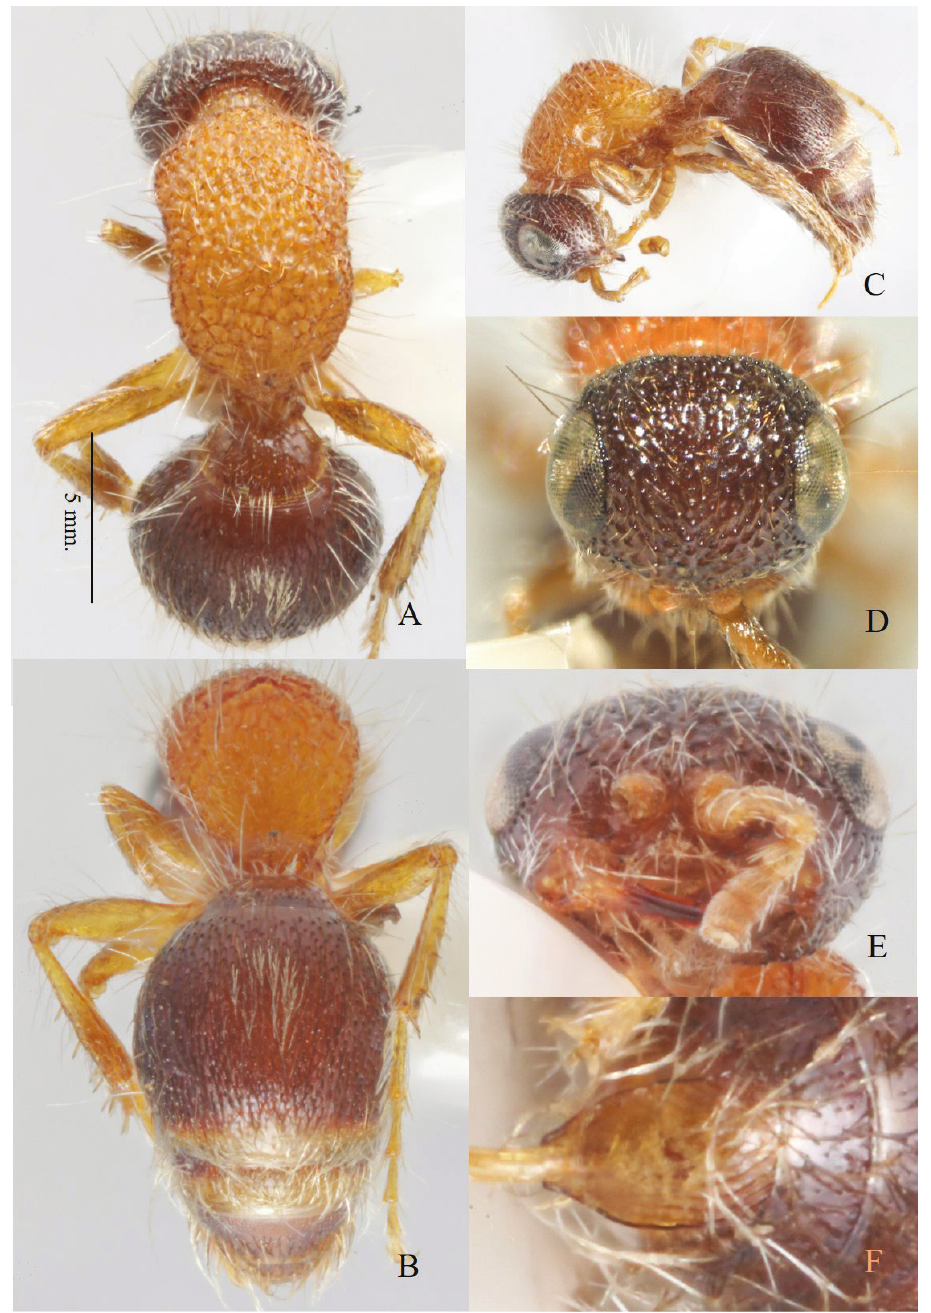
Figure 5. Smicromyrme songkhwae sp.nov., holotype, female A dorsal view B posterior propodeal face and metasoma dorsum C lateral view D frons and vertex E clypeus F